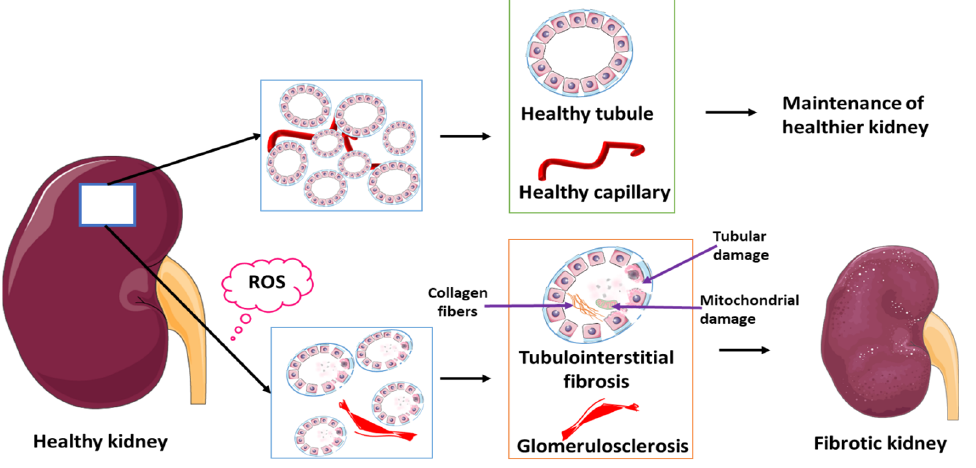
Figure 9. ROS associated with renal fibrosis. Renal fibrosis is mainly associated with inflammation however, it is now widely accepted that ROS also contributes significantly to renal fibrosis. Ischemia/reperfusion is associated with the production of ROS. Ischemia/reperfusion is also one of the major factors associated with the induction of RPN. During fibrosis, renal tubulointerstitial fibrosis, renal parenchyma collapses due to the accumulation of collagen fibers and inflammatory markers. The glomerulus can be scarred and collapse leading to proteinuria. Excessive ROS produc- tion can lead to mitochondrial dysfunction which exacerbates injury of kidney tubules. ROS-reactive oxygen